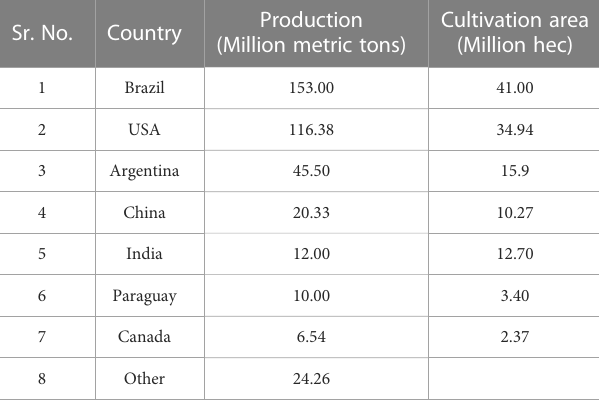
TABLE 1 World top ranked countries for soybean production and cultivation.